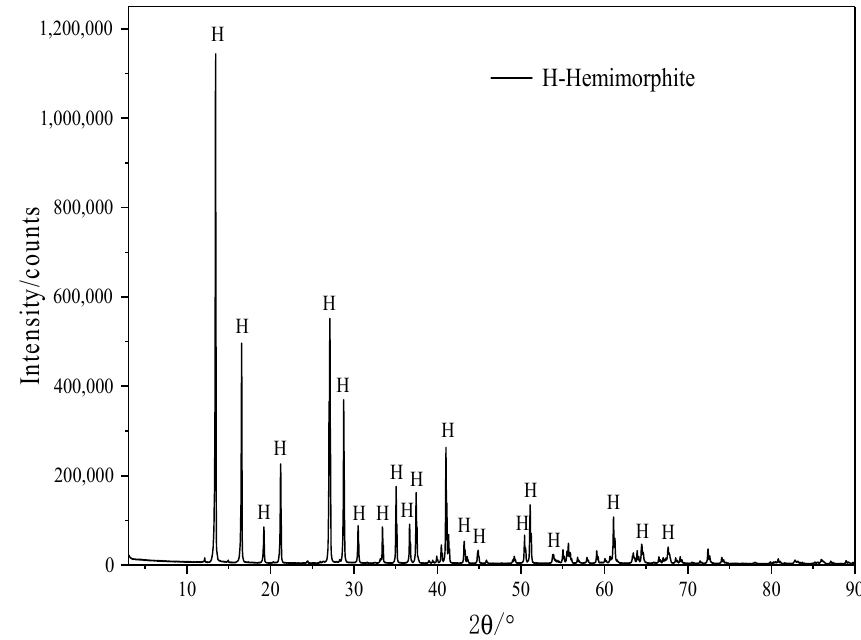
Figure 1. X-ray diffraction (XRD) pattern of the hemimorphite sample. Figure 1. X-ray di ff raction (XRD) pattern of the hemimorphite